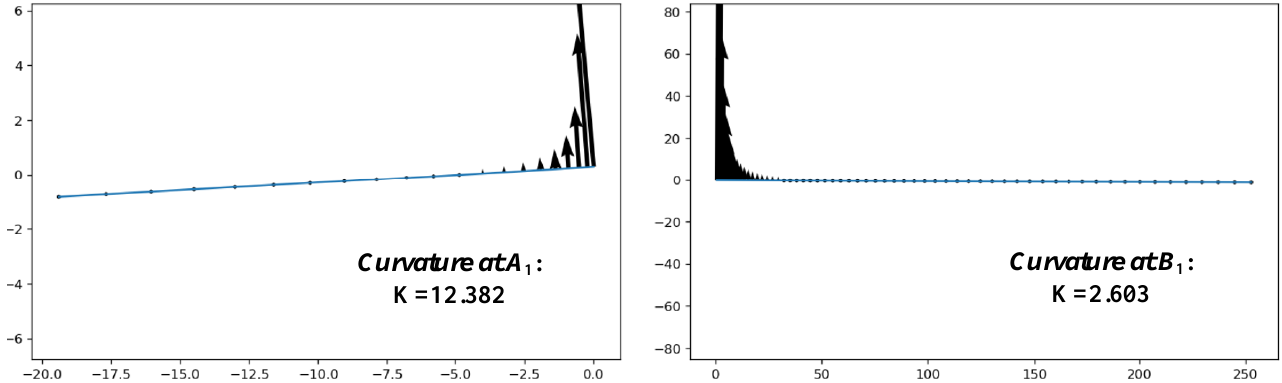
Figure 13. Apple shoulder curvature.